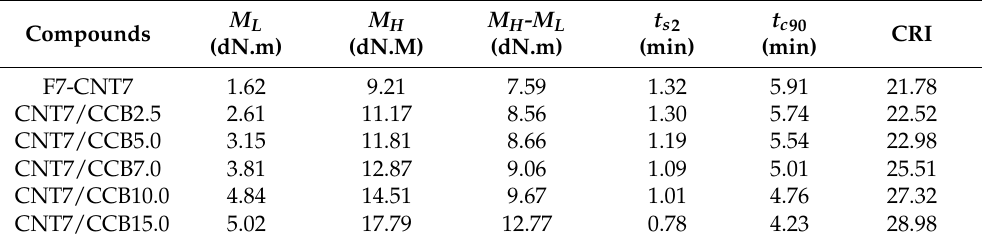
Table 2. Cure characteristics in terms of minimum torque ( M L ), maximum torque ( M H ), torque differ- ence ( M H -M L ), scorch time ( t s 2 ) and cure time ( t c 90 ) of ENR-50 compounded with FeCl 3 (ENR–FeCl 3 )